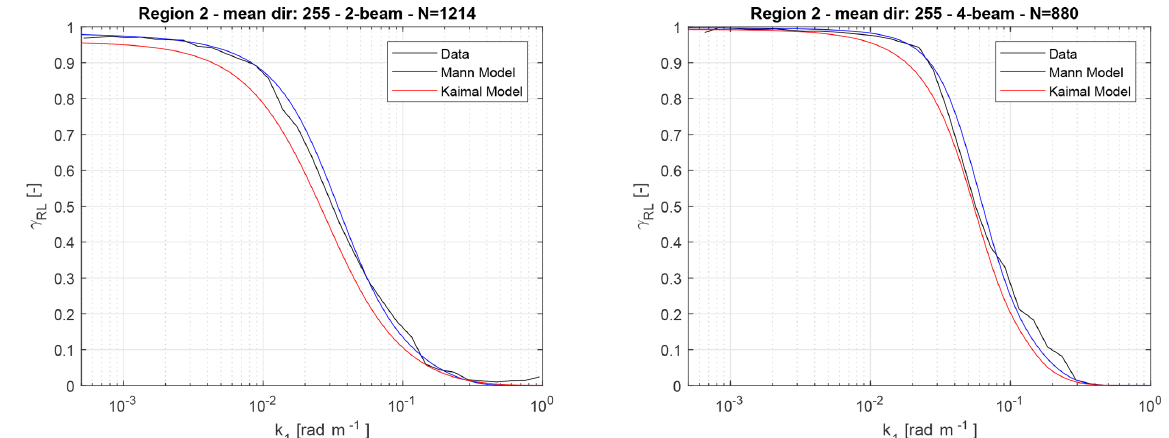
Figure 10. Squared coherence between the REWS estimation of the lidar and the turbine for region 2. The two models are also included in the plot.